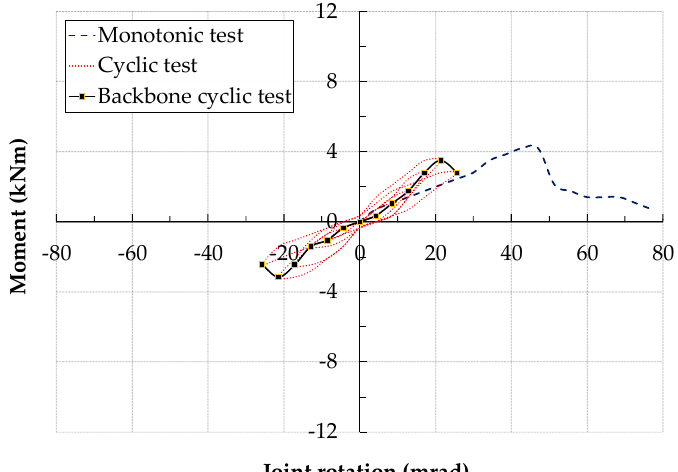
Figure 7. Cyclic moment-rotation response: SFStc2A-hybrid joint with flange only steel cleats.